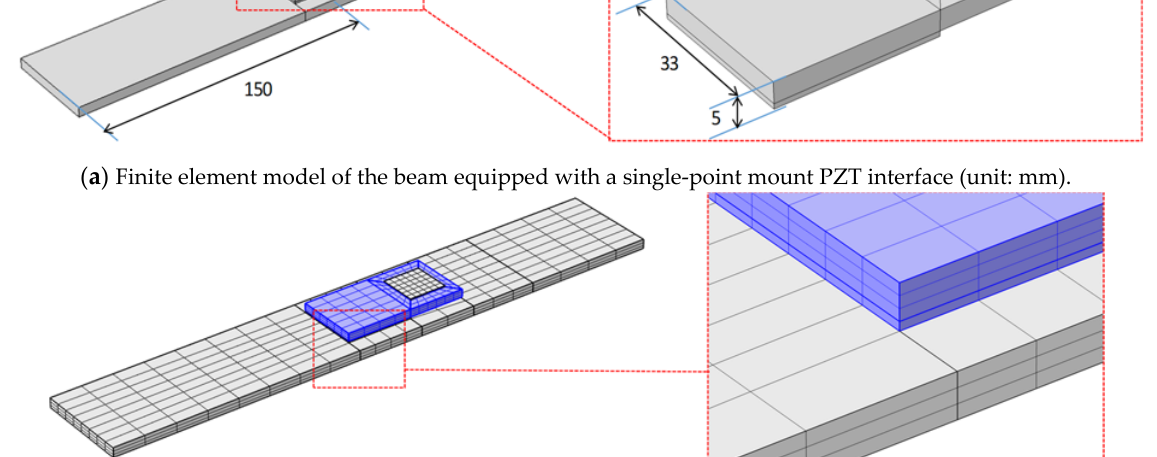
( b ) Meshed finite element model.